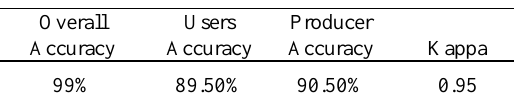
Table 3. Accuracy Assessments